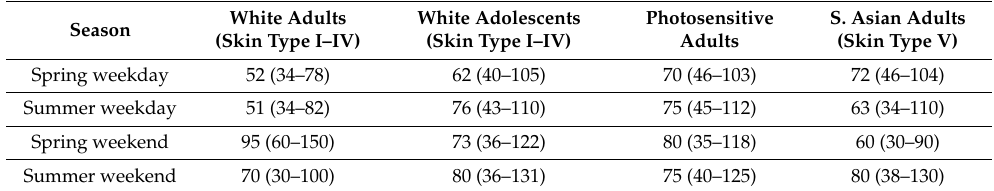
Table 2. Median (IQR) minutes spent outdoors per